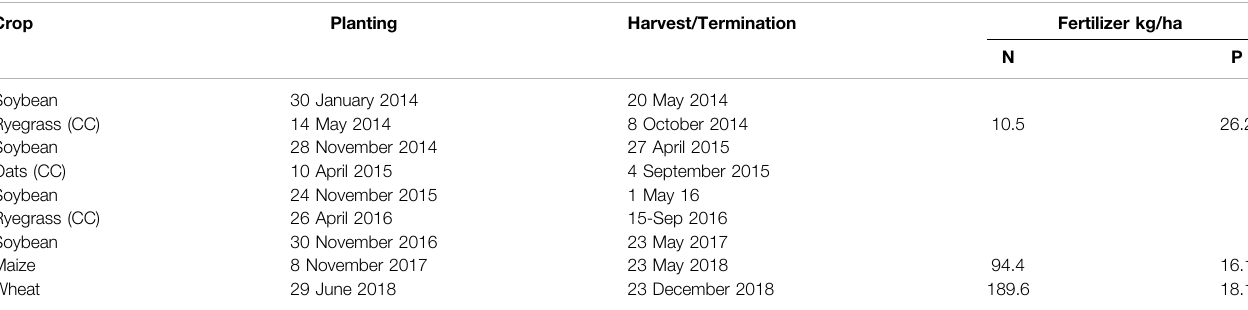
TABLE 1 | Planting and harvest dates and average fertilizer rates per year and crop since uniform management started in 2014 (CC: cover crop). Crop Planting Harvest/Termination Fertilizer kg/ha